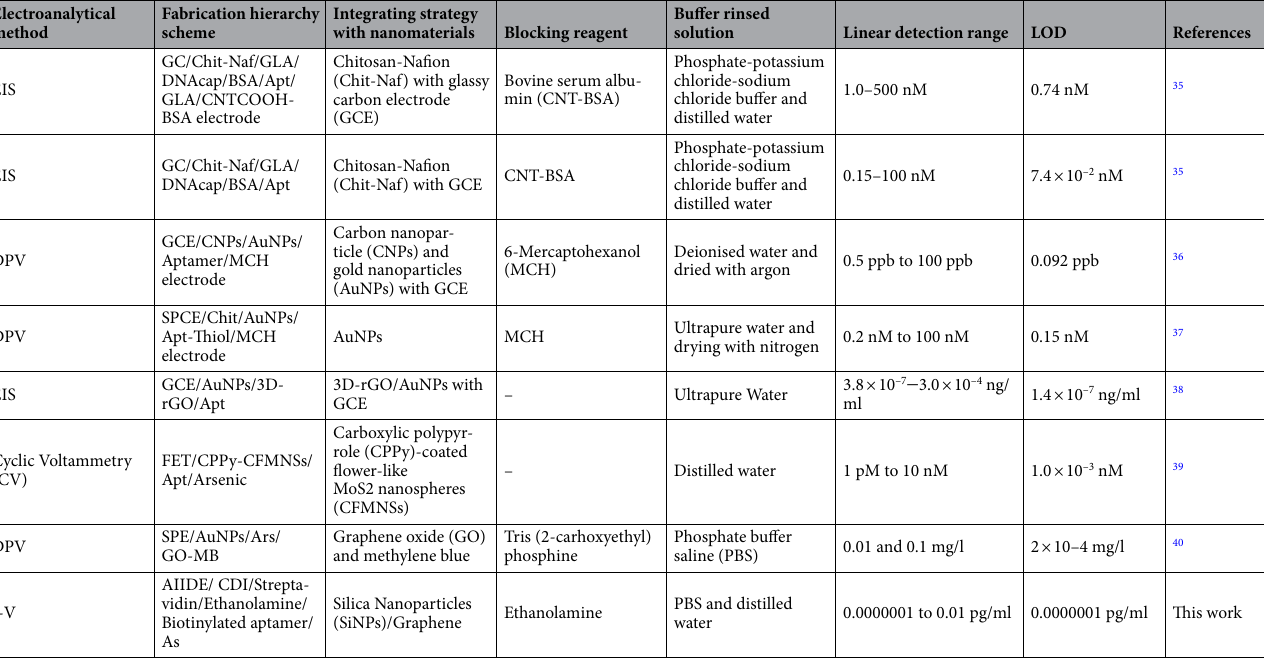
Table 1. Currently available electrochemical aptasensors for arsenic